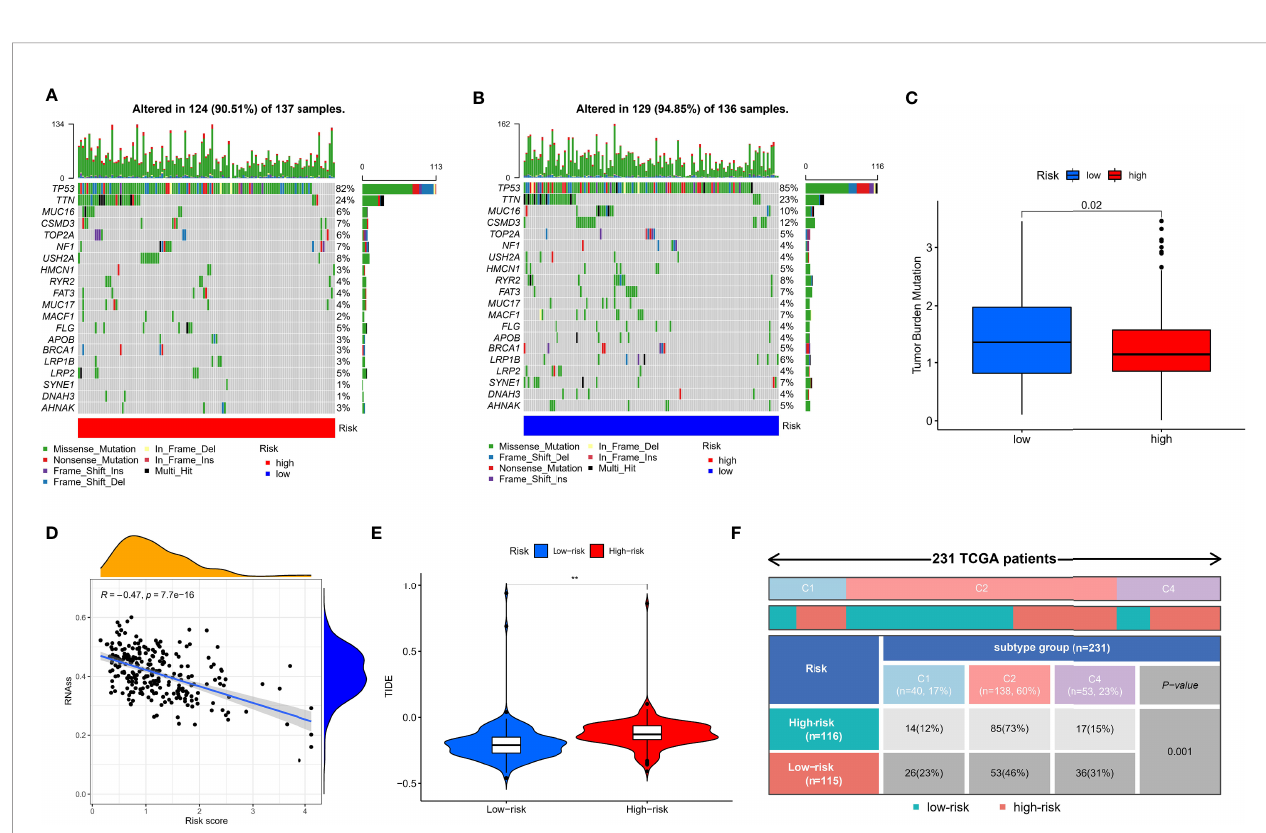
FIGURE 9 | Mutation, TIDE, and stemness characteristics in different risk groups. (A) Frequency of somatic mutations in the high-risk group. (B) Frequency of somatic mutations in the low-risk group. (C) Analysis of differences in TMB score of different risk groups. (D) Correlation analysis of hypoxia risk score with stemness score. (E) Analysis of differences in TIDE score of different risk groups. (F) The distribution of immunological subtypes in different risk groups. **p <